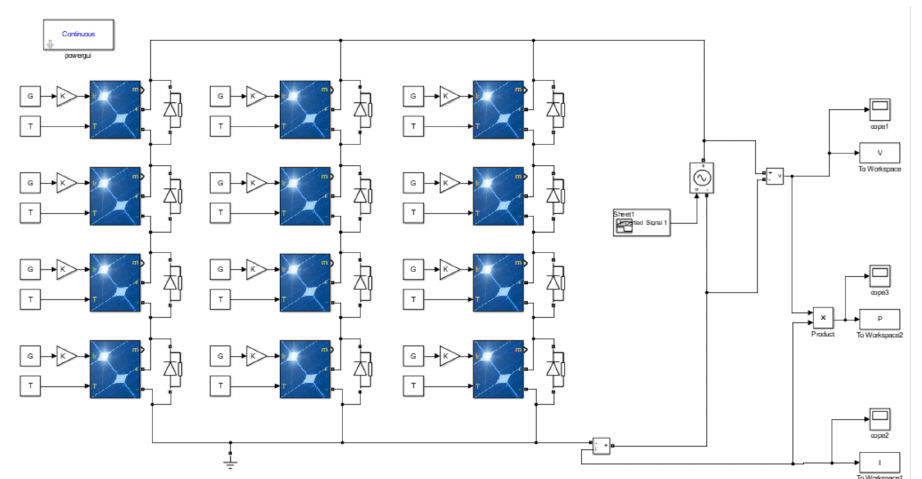
Figure 9. PV array model.